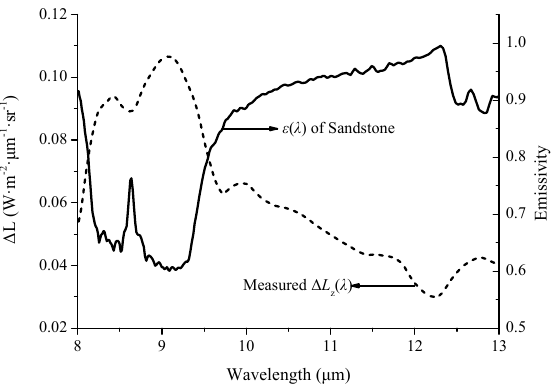
Figure 5. Comparison results between the average spectrum of radiance increment with the exten- sional fissure mode and the static emissivity spectrum of sandstone.